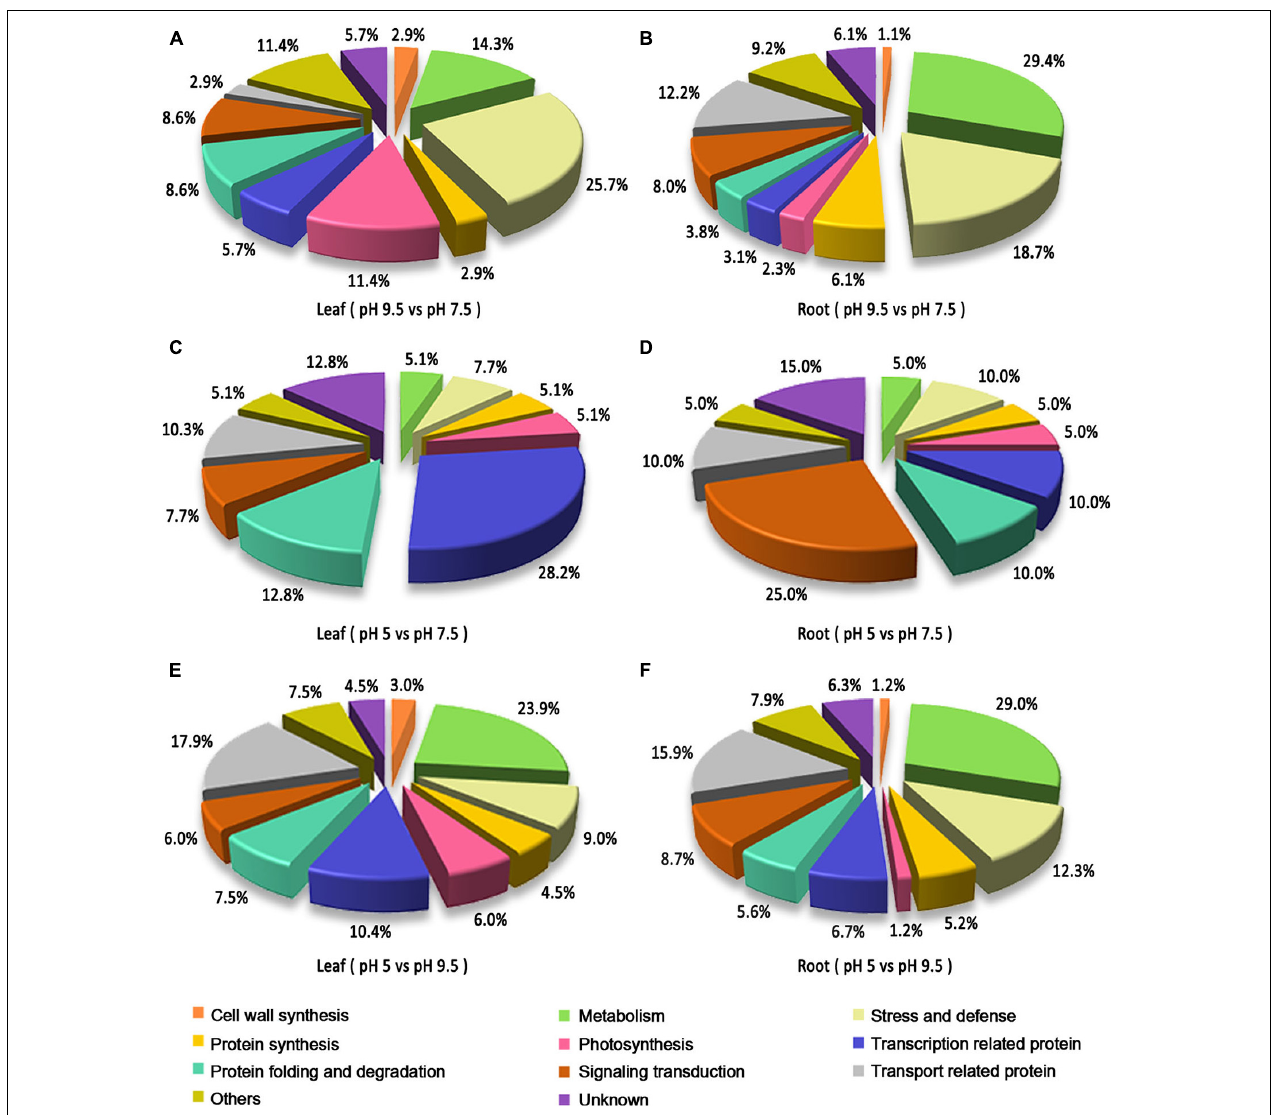
FIGURE 4 | Functional classification of the identified differentially expressed proteins (DEPs) in the leaves and roots of sugar beet in different pH comparison groups. Functional classification of DEPs in leaf (A) and root (B) in the group of pH 9.5 vs. pH 7.5. Functional classification of DEPs in leaf (C) and root (D) in the group of pH 5 vs. pH 7.5. Functional classification of DEPs in leaf (E) and root (F) in the group of pH 5 vs. pH